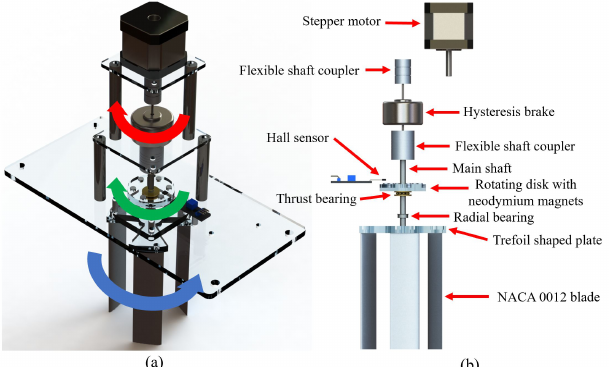
A 3D rendered picture of the single tower apparatus ( a ) showing the three types of torque exerted on the system: hydrodynamic torque (positive in blue), brake torque (negative in red), and mechanical loss (negative in green) and critical mechanical components ( b ). The stepper motor can be frictionally or permanently (via two M3 set screws) engaged to the system through a shaft